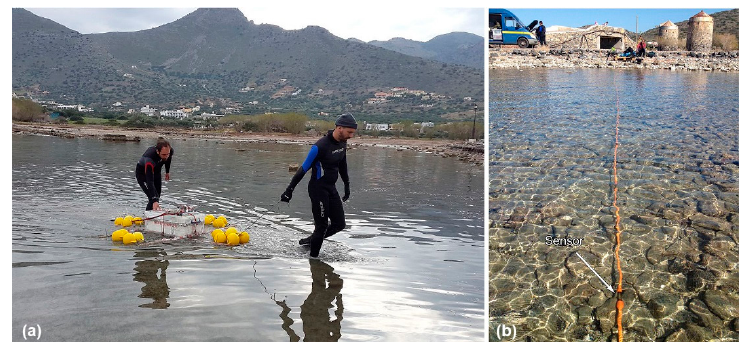
Figure 5. ( a ) Dynamic electrical resistivity tomography (ERT) data acquisition along individual lines apparatus; ( b ) Cable used for the acquisition of static submerged ERT data.